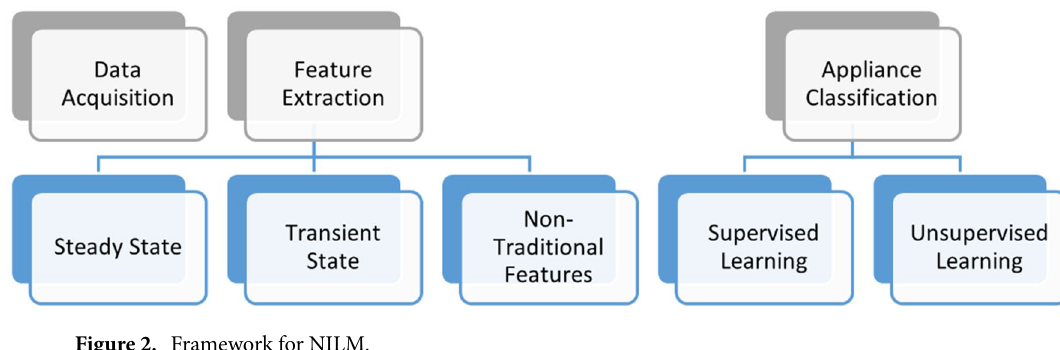
Figure 2. Framework for